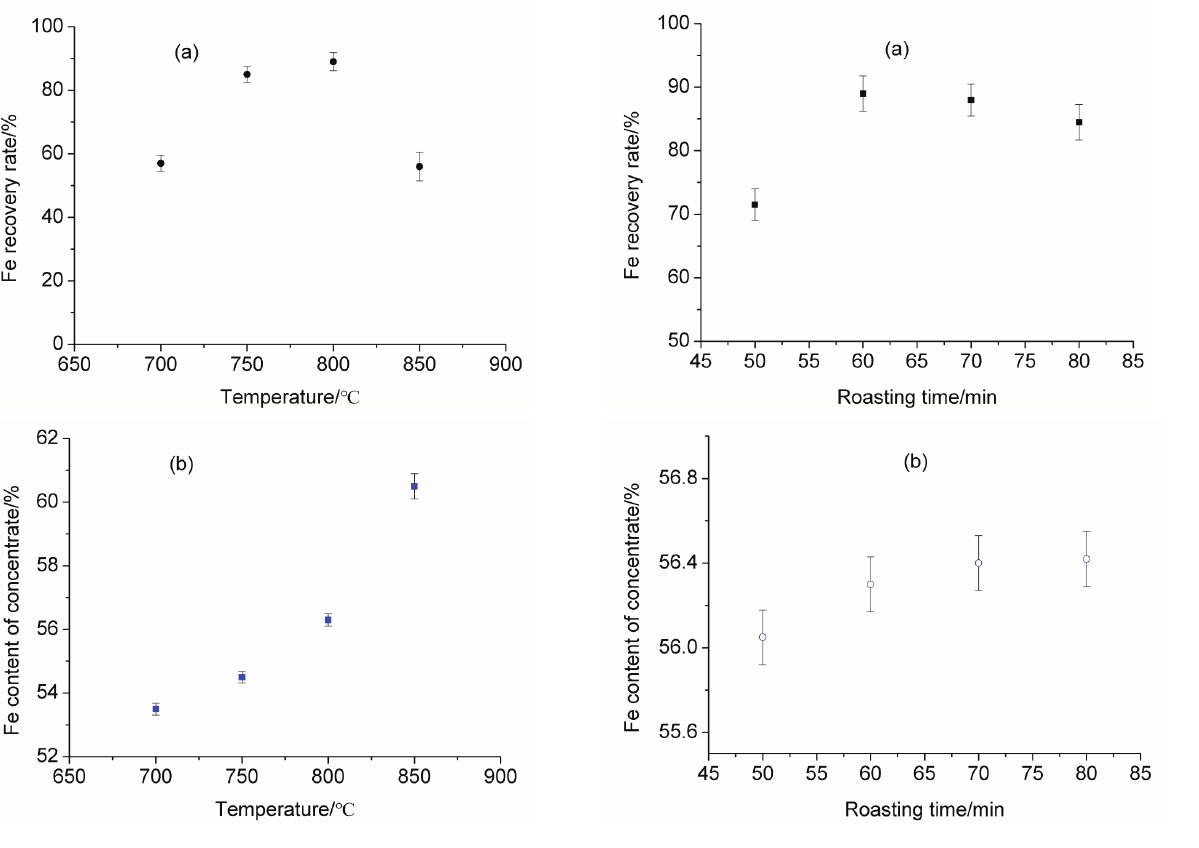
Figure 3: Roasting temperature (700 ~ 850 o C) on magnetic roasting result of (a) Fe recovery, and (b) Fe content of fi nal concentrate.